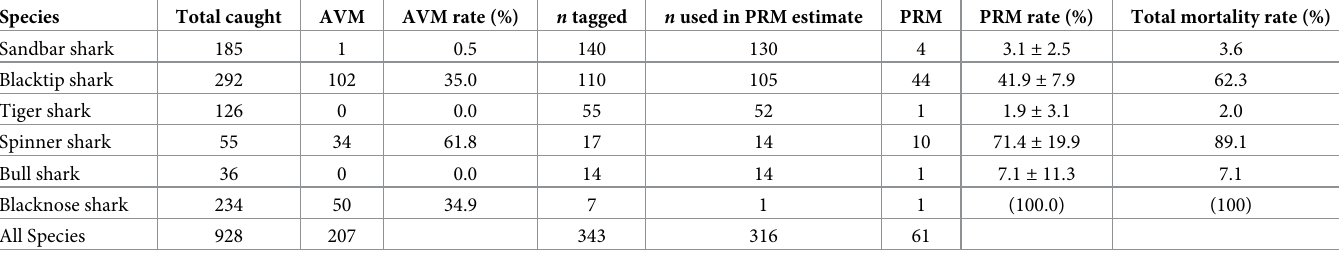
Table 2. Species-specific catch numbers, at-vessel mortality (AVM), post-release mortality (PRM), and total mortality rates.